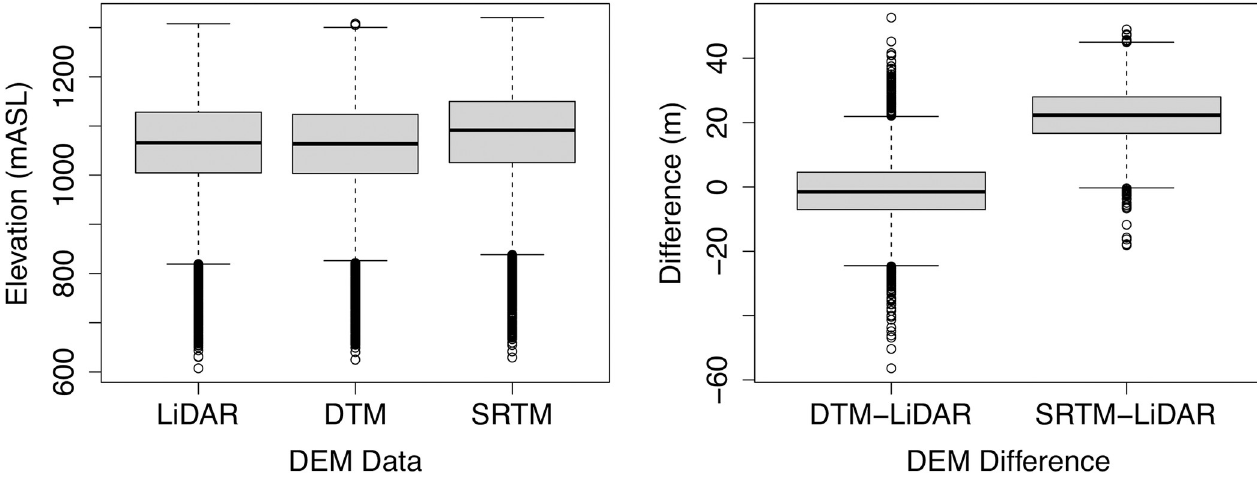
Fig 2. Elevation range in metres above sea level (mASL) for the LiDAR 1m DEM, VicMap Elevation DTM and SRTM DEM (left) and the difference in elevation between LiDAR 1m DEM and the VicMap Elevation DTM (LiDAR 1m-DTM) and SRTM DEM (LiDAR 1m-SRTM).